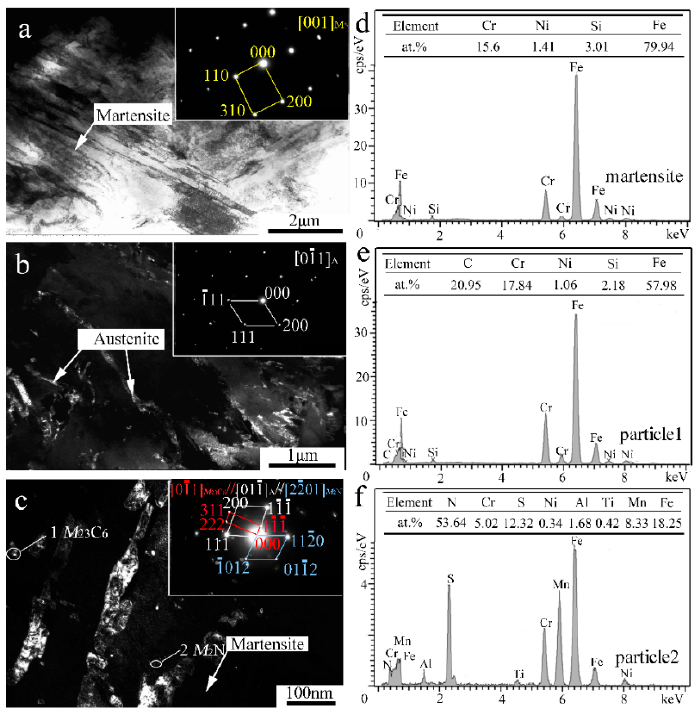
Figure 4. TEM results of the V-free MSS coating: ( a ) Bright-field (BF) image and SAED pattern of M; ( b ) Dark-field (DF) image and SAED pattern of A; ( c ) DF image and SAED pattern of M 23 C 6 ; ( d ) EDS analysis of martensite; and ( e , f ) EDS analysis of particles 1 and 2 denoted in ( c ), respectively.